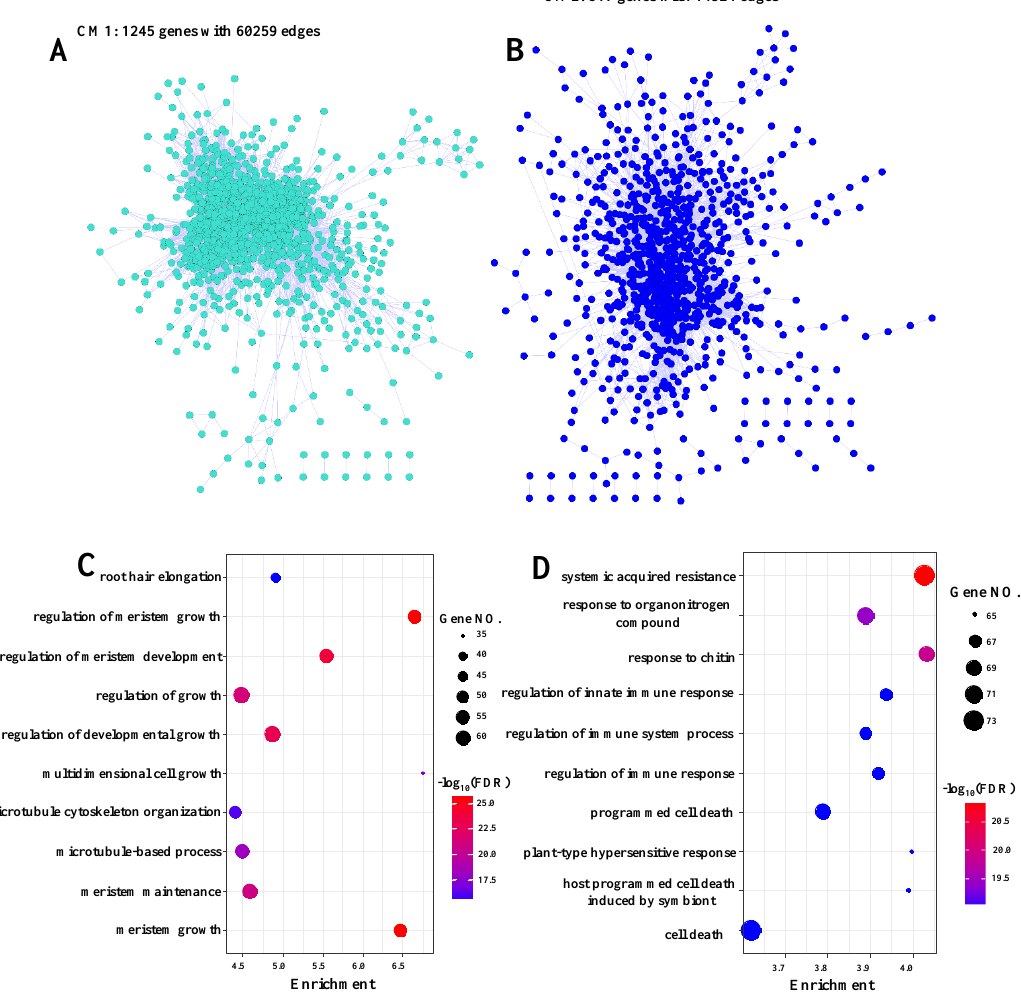
Figure 6. Gene co-expression networks of co-expression module 1 (CM1, ( A )) and co-expression module 2 (CM2, ( B )). The nodes and edges represented the genes and the significant correlations between genes, respectively. Genes without any edges were not showed in the network. The top ten significantly enriched GO terms in biological process in CM1 (C) and CM2 (D).